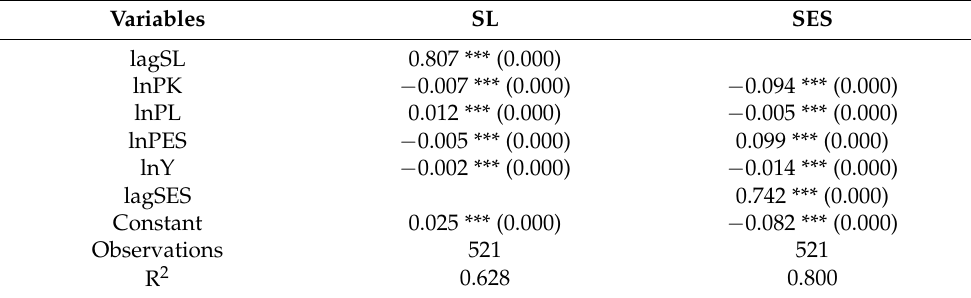
Table 4. The results of the cost share equations.